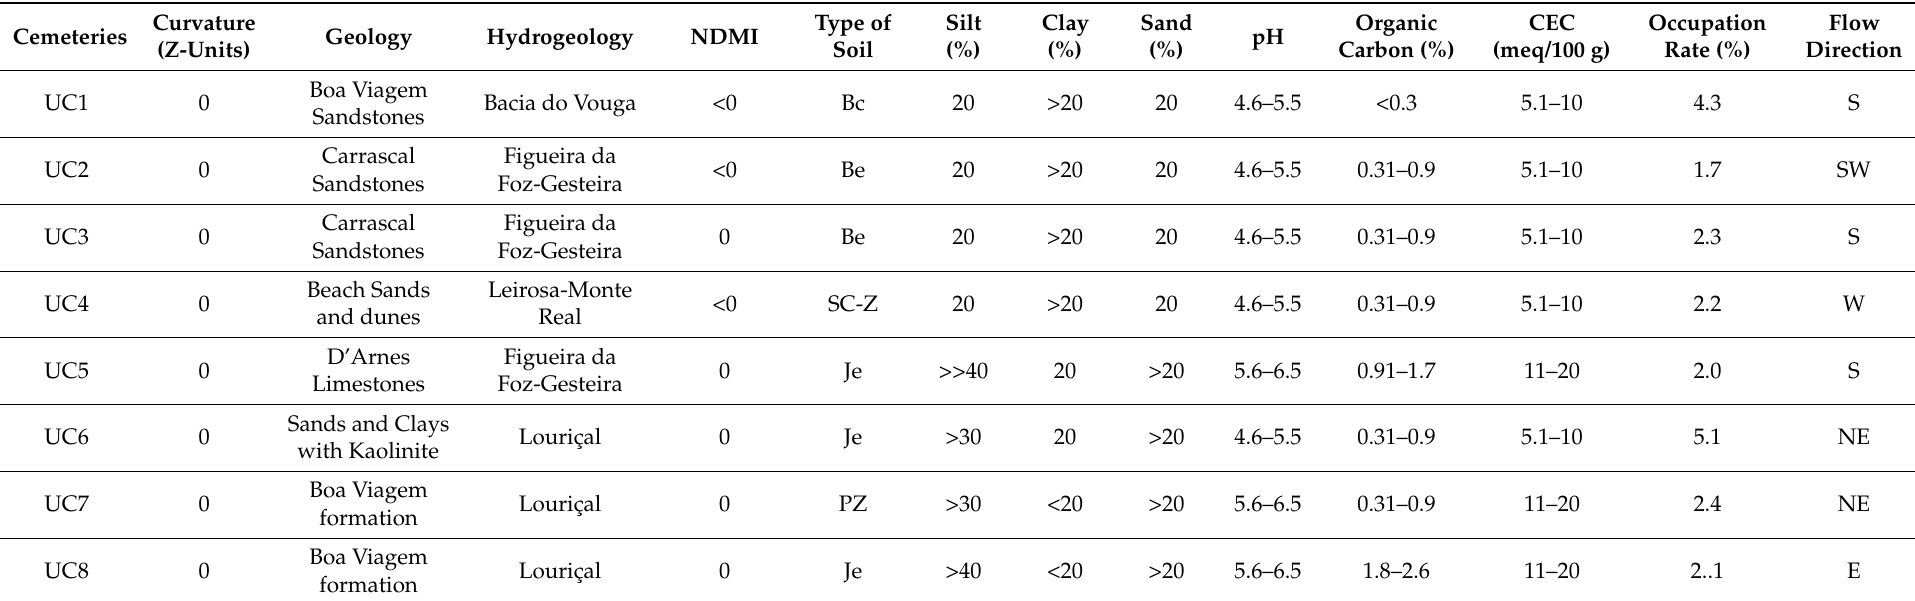
Table 2. Information for developing the site characteristic